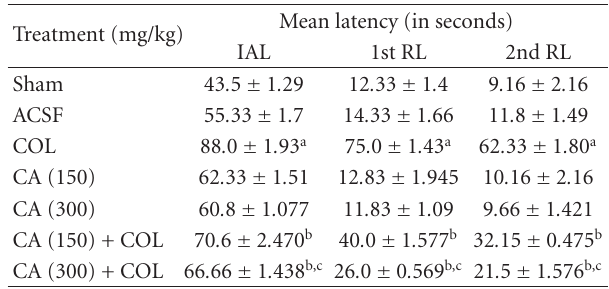
Table 3: E ff ect of Centella asiatica (CA; 150 and 300 mg/kg, PO) on spatial navigation task in intracerebroventricular colchicines- (COL-) injected